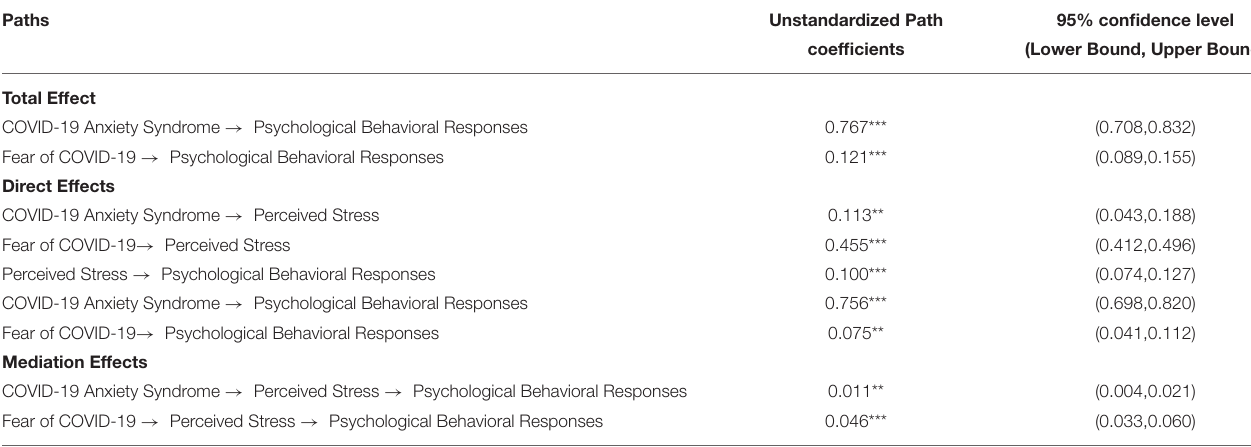
TABLE 4 | Structural model assessment.